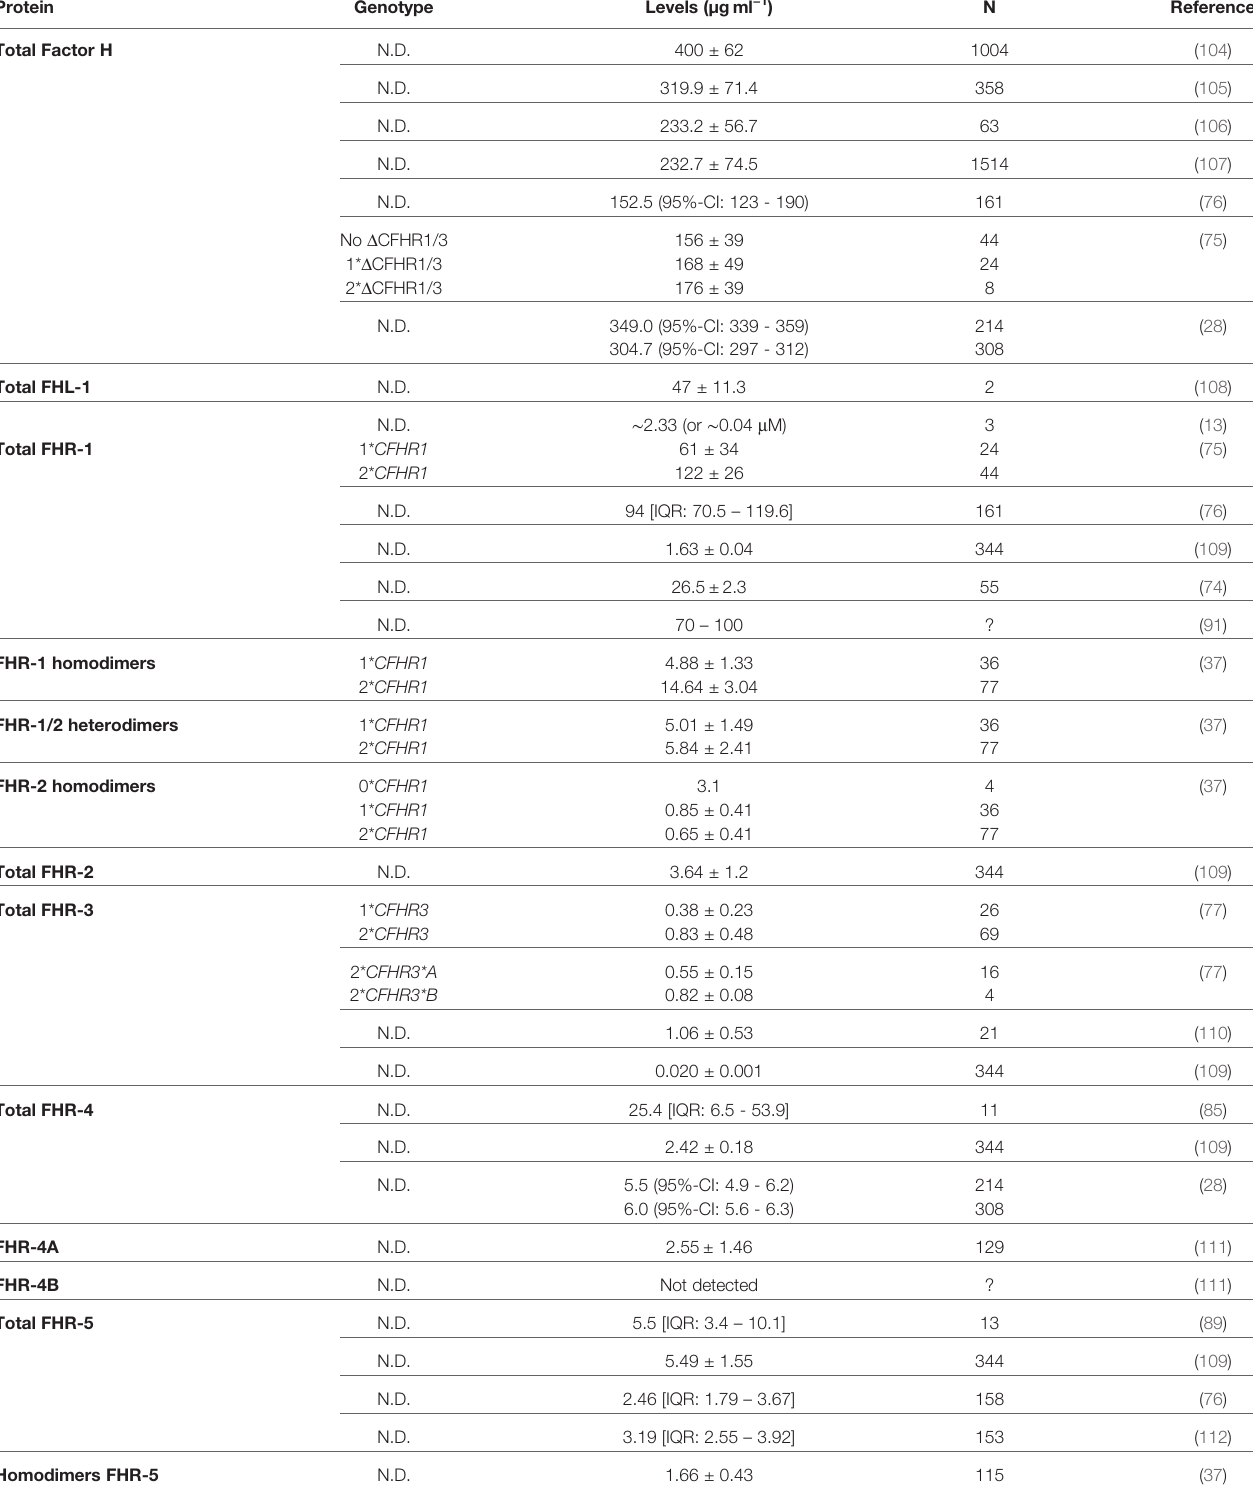
TABLE 1 | Previously published systemic levels of the Factor H protein family.